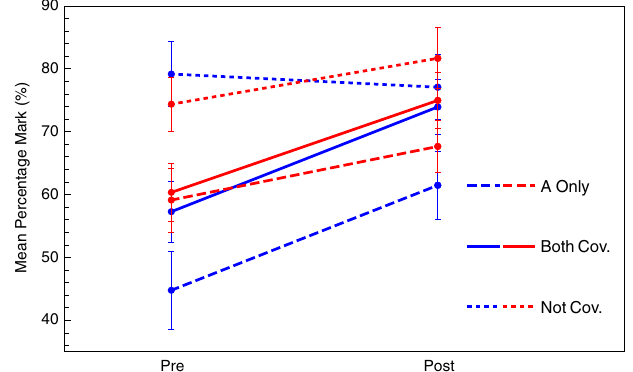
FIG. 4. Mean physics pre- and post-test scores for female (blue lines) and male (red lines) students, for each level. A Only (dashed lines) refers to the questions that were A Level difficulty (questions 2, 5, 6, and 8). Both Cov. (solid lines) refers to the questions that were both GCSE and A Level difficulty, and were covered (questions 1, 4, 7, and 10), while Not Cov. (dotted lines) refers to those that were not covered at all (questions 3 and 9). Errors bars denote the standard error of the